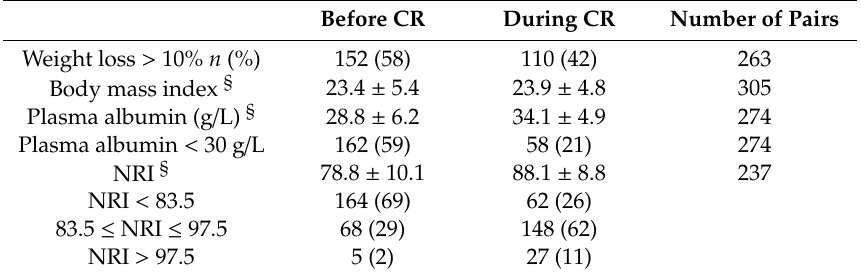
Table 4. Evolution of nutritional status between before and during chyme reinfusion (CR). Before CR During CR Number of Pairs Weight loss > 10% n